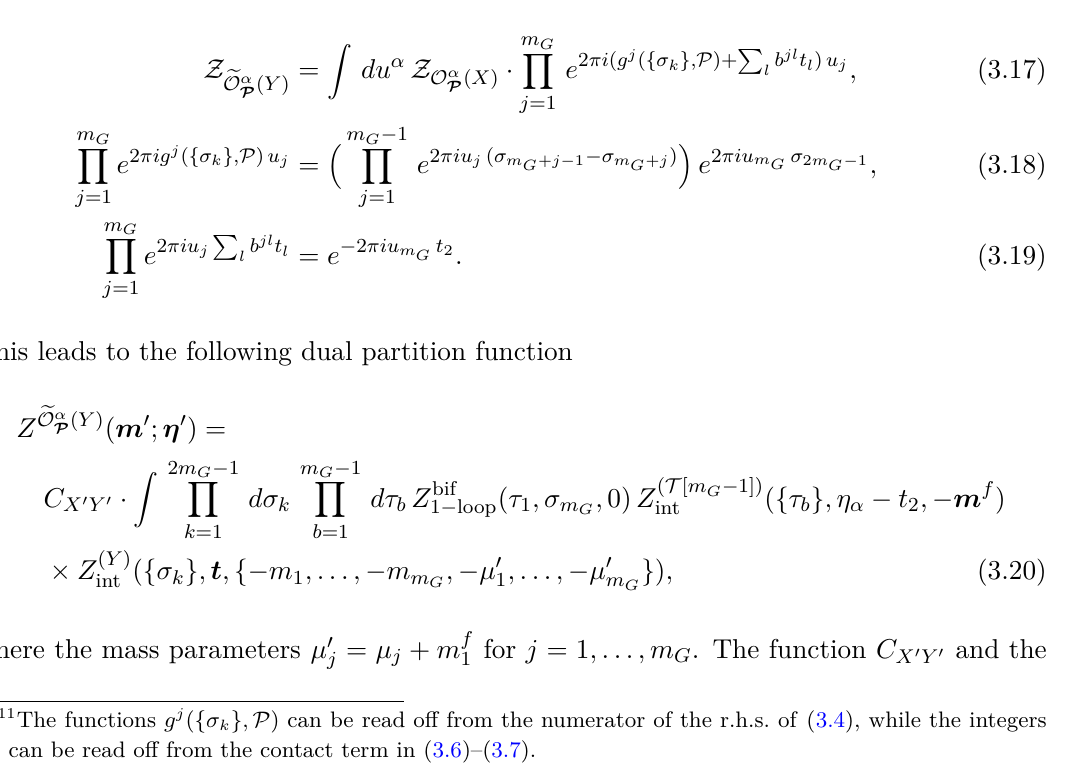
The dual theory can be read off from the general construction in (2.19)–(2.20),